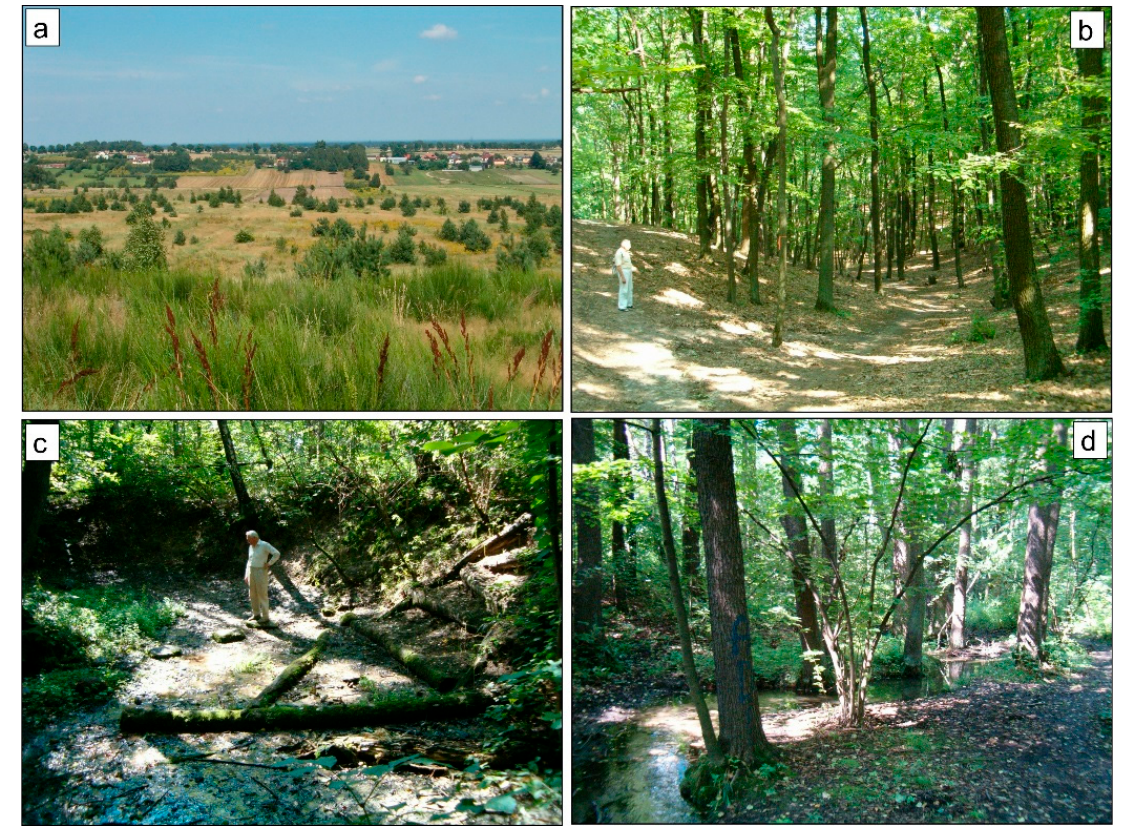
Figure 3. Examples of non-urbanised landscapes in the Ł ód ź area. ( a ) edge zone of the Ł ód ź Heights; ( b ) a ravine in Ł agiewnicki Forest in the edge zone of the Ł ód ź Heights; ( c ) lateral spring niche in the initial course of the Bzura River; ( d ) bottom of the Bzura River valley in its spring section (photo A. Szmidt 2006).